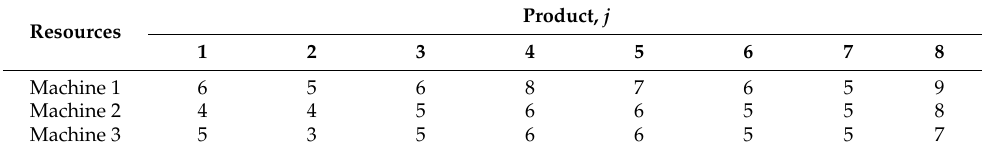
Table 4. Raw fish for each Product (ton).